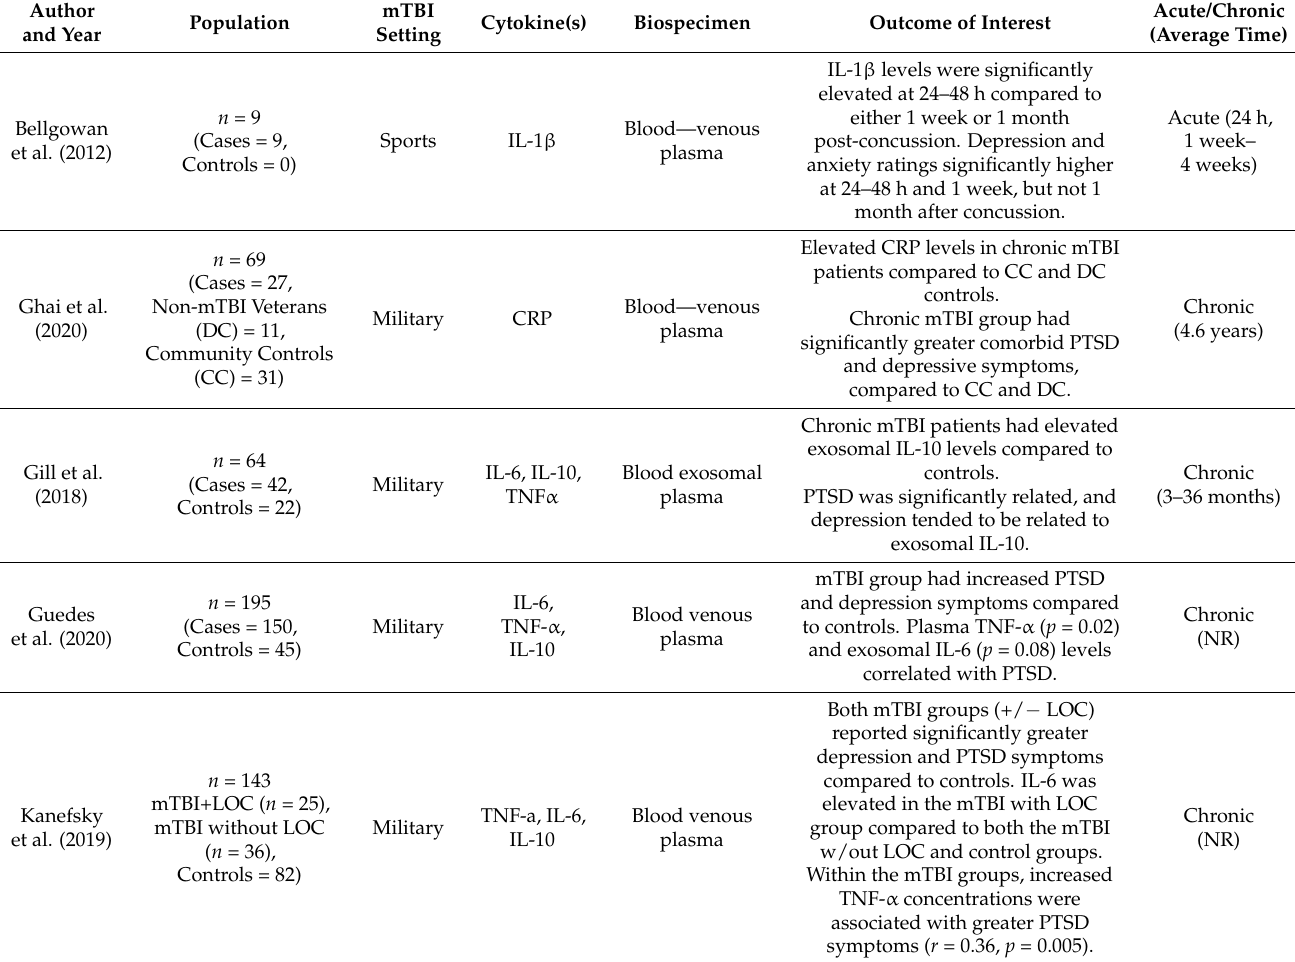
Table 1. Study characteristics and